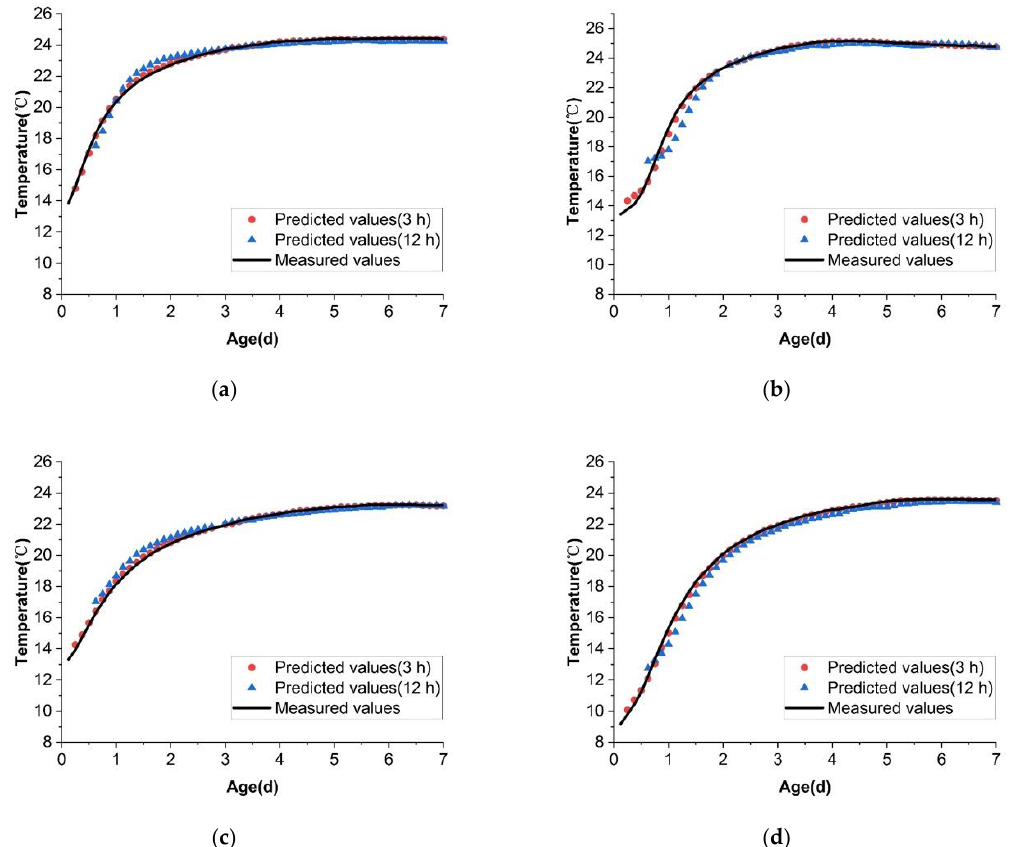
Figure 7. Comparisons of predicted and measured temperatures for Baihetan dam: ( a – d ) the predicted and measured values of the four old concrete blocks, respectively.